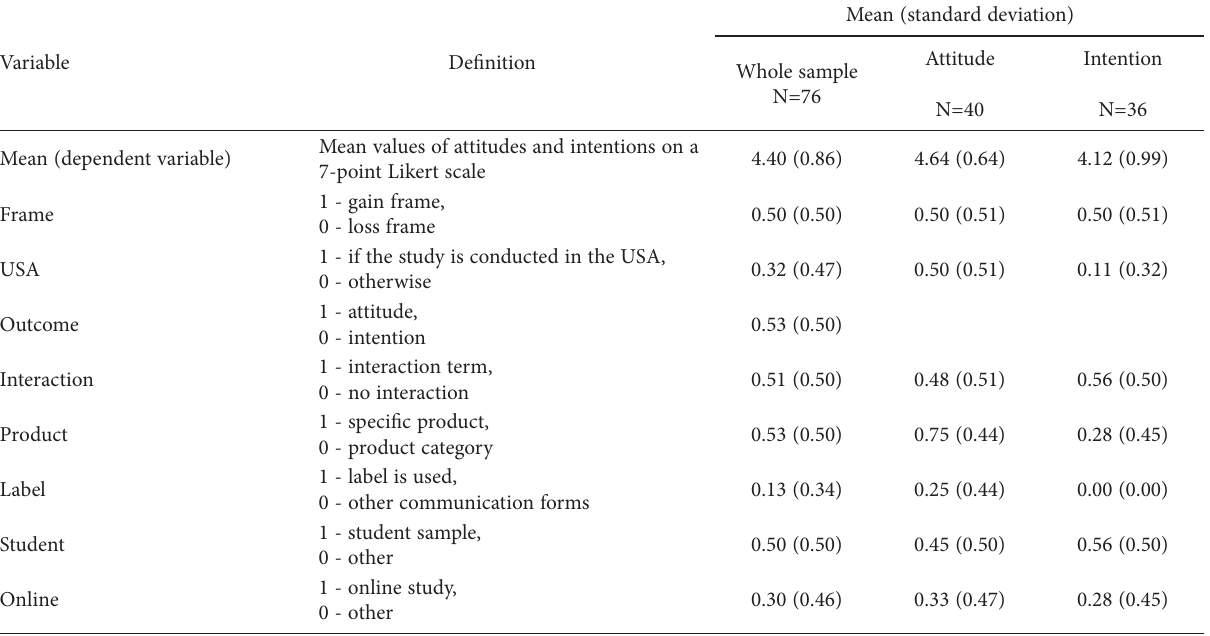
Table 2. Definitions and means and standard deviations of variables included in the analysis.